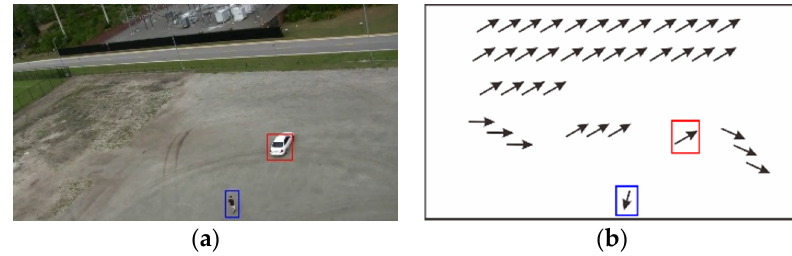
Figure 6. Optical flow estimation: ( a ) Original image, ( b ) motion vectors.